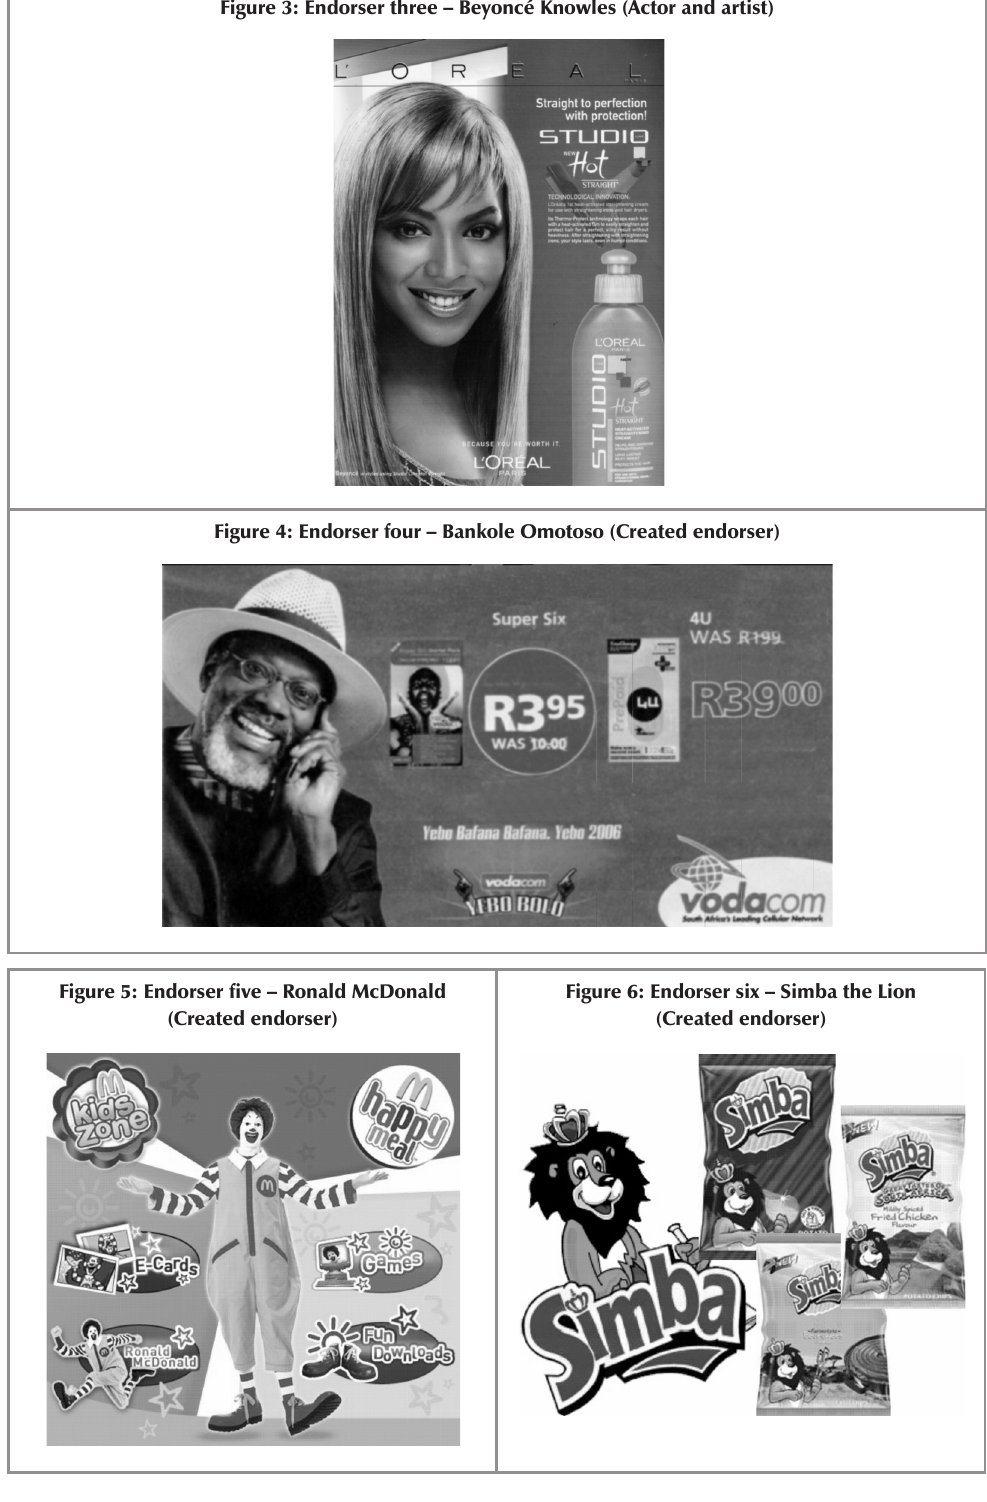
Figure 3: Endorser three – Beyoncé Knowles (Actor and artist)